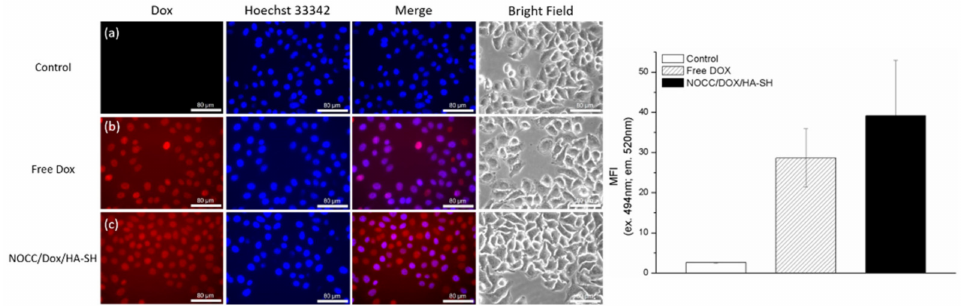
Figure 5. Cellular uptake of ( a ) blank, ( b ) free Dox, and ( c ) NOCC/Dox/HA-SH by fluorescence microscopy in HeLa cells after 8 h of incubation. The data are shown as means ± SD (n = 3).